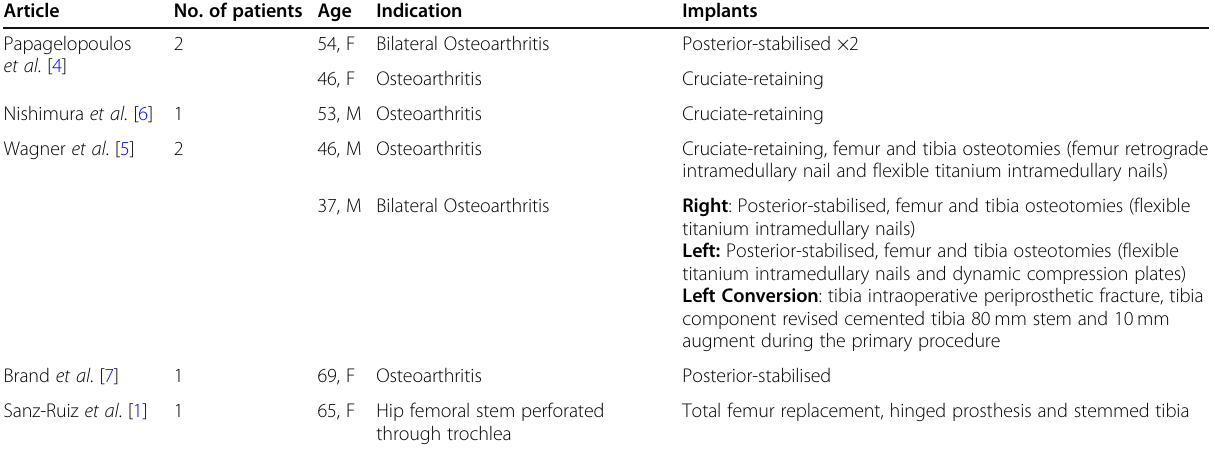
Table 1. Five posterior stabilised, three cruciate retaining and a single hinge implants were used in the total knee re- placements. All the procedures were indicated for second- ary osteoarthritis except the single case of a total femur Table 1 Published articles with total knee replacements for Osteogenesis Imperfecta Article No. of patients Age